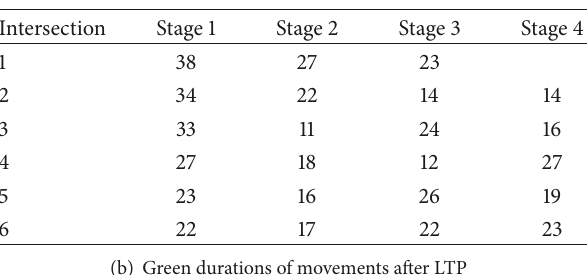
Table 3: Green durations of stages before and after LTP (s). (a) Green durations of movements before